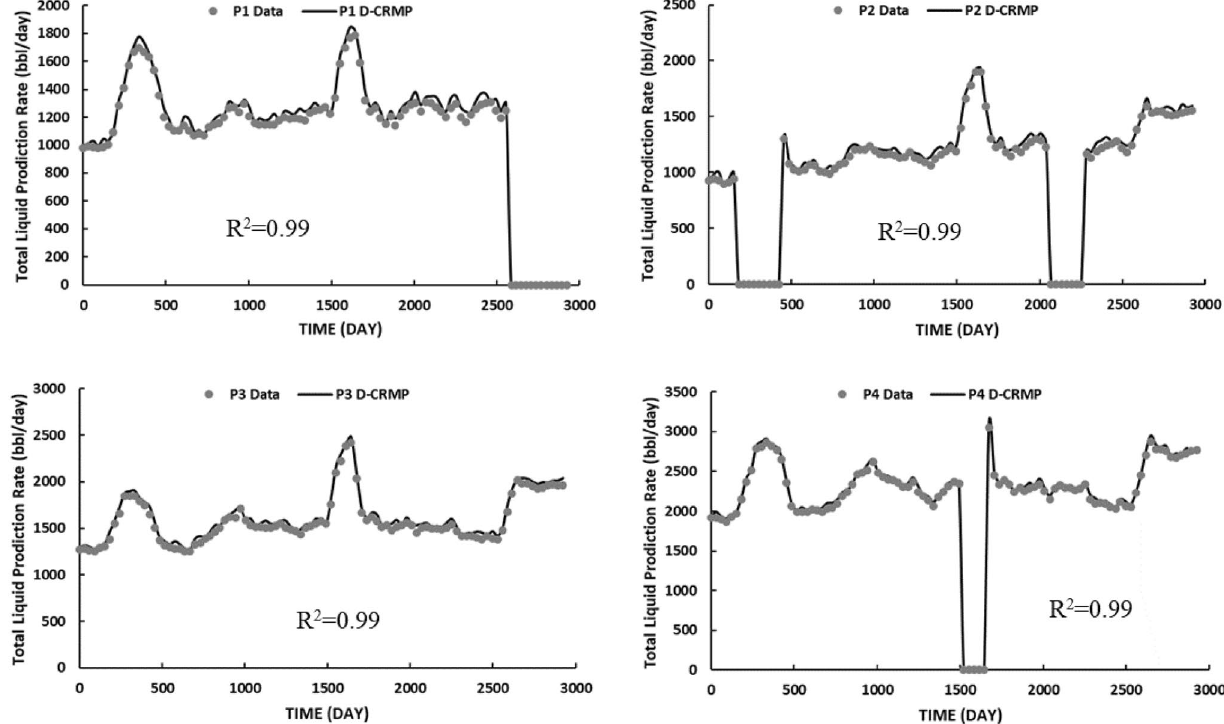
Fig. 10 Liquid production rates match by D-CRMP in case